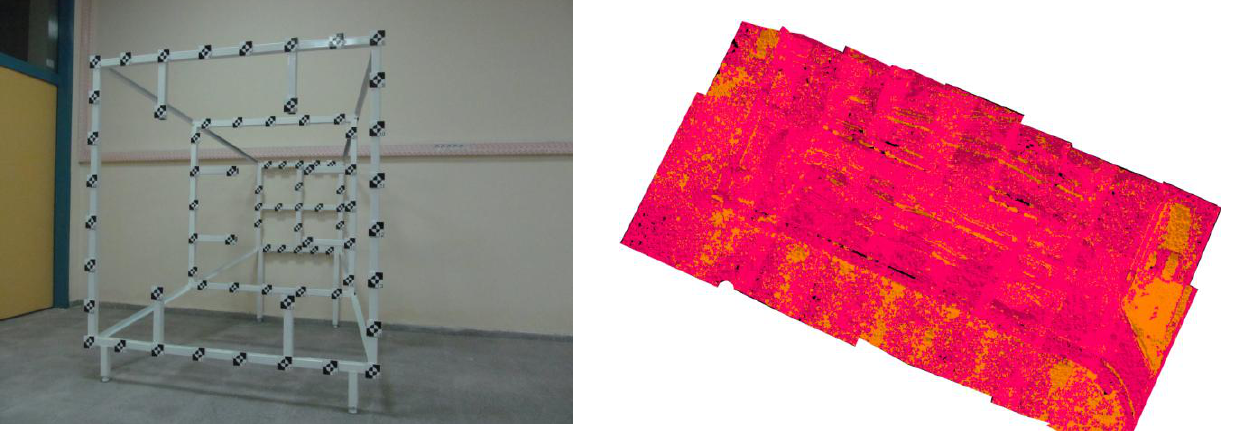
Figure 5. 3D test object for geometric camera calibration